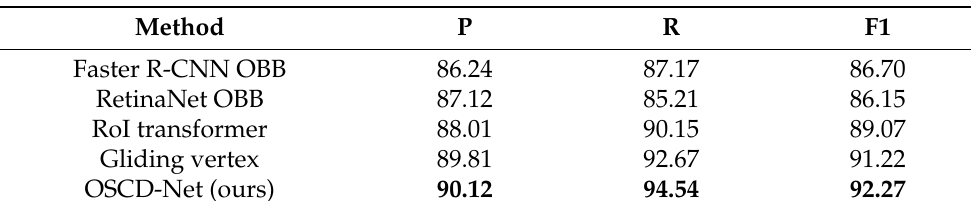
Table 4. Performance evaluation with Precision(P), Recall(R) and F1 on the HRSC2016 dataset. The highest value is indicated by bold numbers (%).